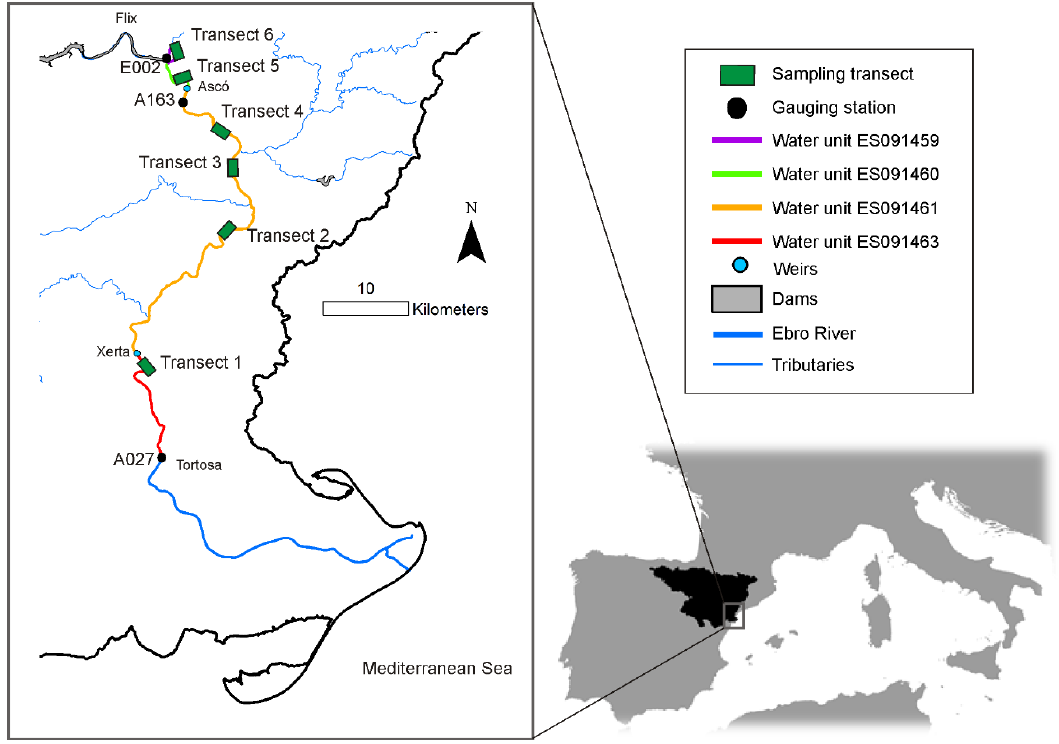
Figure 1. Study area showing the sampling transects and gauging stations located on the water units (masses) of the low Ebro River (dams and weirs are also showed).